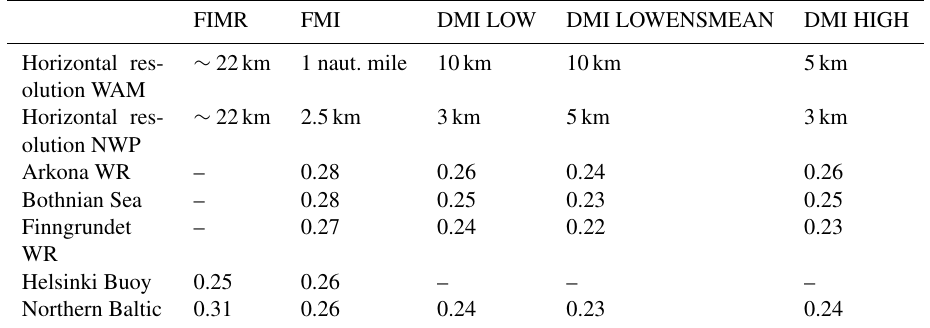
Table 5. Comparison of RMSE for SWH of 6h forecast runs for selected sites. FIMR values are from Tuomi et al. (2008) and FMI values are from Tuomi et al. (2017).